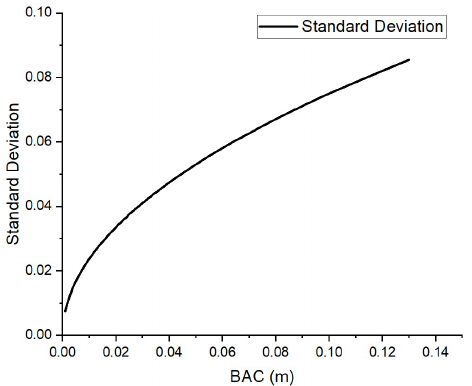
Processes 2021 , 9 ,